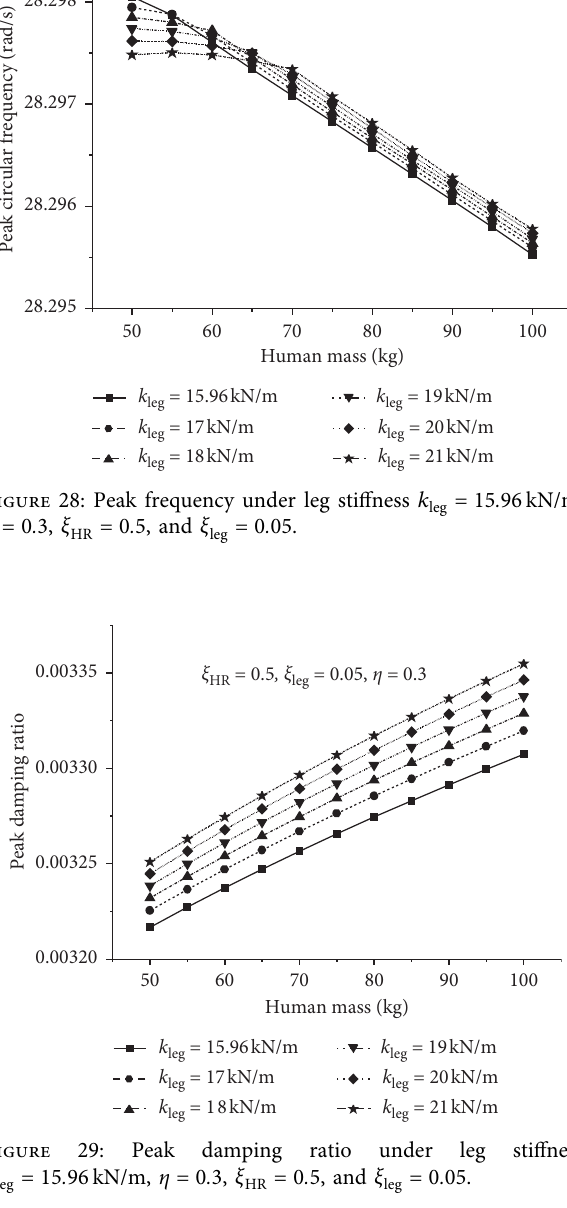
� 0 . 5, η � 0 . 3, and HR